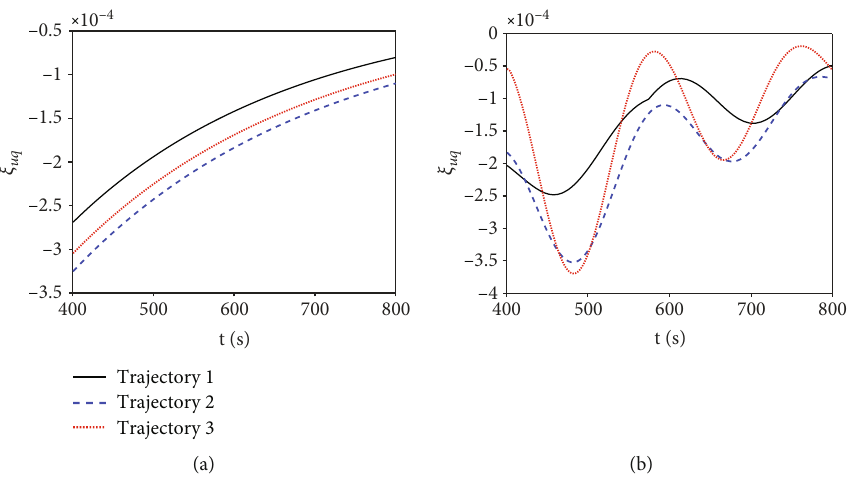
Figure 1: The variation of ξ